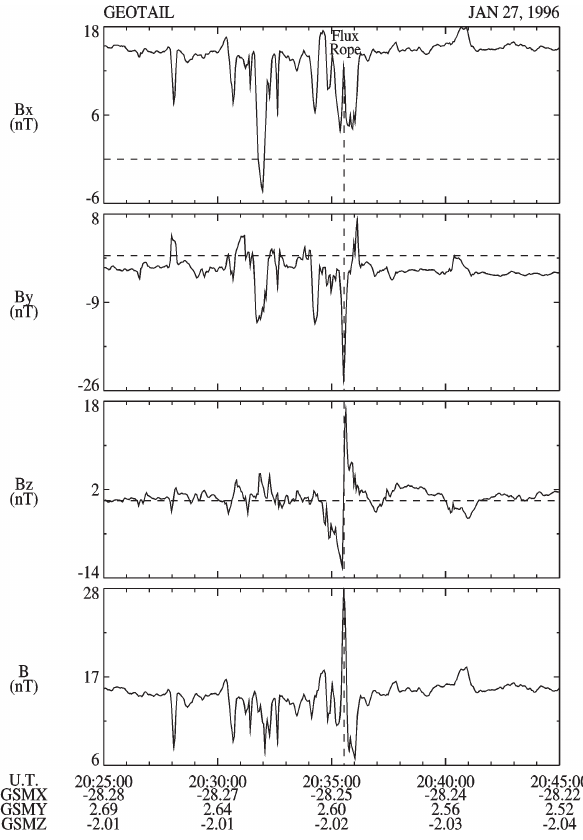
Fig. 4. Geotail observations of a flux rope with a strong core field (HFR) on 27 January 1996. The 3 GSM components of the mag- netic field and its magnitude are presented. Note the negative pos- itive bipolar signature in the B z component, and the central field magnitude enhancement greatly in excess of the background lev- els. This observation is thus consistent with a flux rope structure which contains a central force-free field region. (From Slavin et al.,